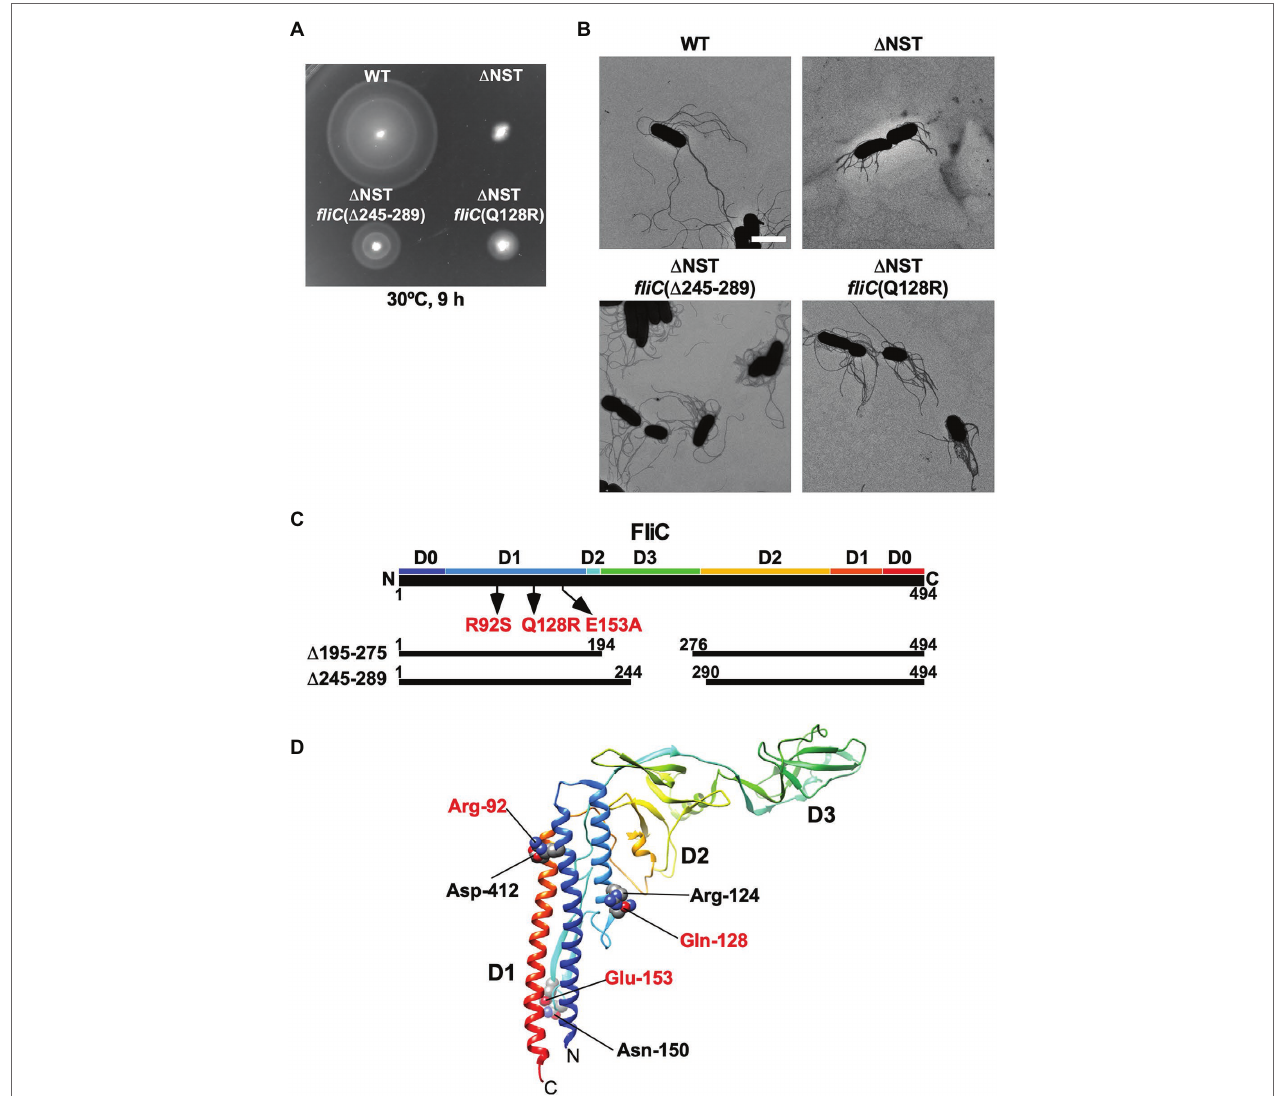
FIGURE 4 | Isolation of pseudorevertants from the ∆ NST mutant. (A) Motility of WT, ∆ NST and its bypass mutants, ∆ NST fliC ( ∆ 245–289) and ∆ NST fliC (Q128R). Plates were incubated at 30 ° C for 9 h. (B) Electron micrographs of WT, ∆ NST, ∆ NST fliC ( ∆ 245–289), and ∆ NST fliC (Q128R) cells. Cells were negatively stained with 0.5% (w/v) phosphotungstic acid (pH 6.5). Micrographs were taken at a magnification of ×1,200. Scale bar, 2 μ m. (C) Locations of bypass mutations in FliC. FliC consists of four domains, D0, D1, D2, and D3. The point mutations in FliC are indicated by arrows. In-frame deletion variants of FliC lacking residues 195–274 and residues 245–289 are shown by solid lines. (D) Location of mutated residues in the atomic structure of the F41 fragment of Salmonella FliC (PDB ID: 1IO1). The F41 fragment of FliC, which lacks N-terminal 52 and C-terminal 44 residues, consists of domains D1, D2, and D3. The C α backbone is color-coded from blue to red, going through the rainbow colors from the N- to the C-terminus. Arg-92, Gln-128, and Glu-153 interact with Asp-412, Arg-124, and Asn-150, respectively, to stabilize domain D1 of